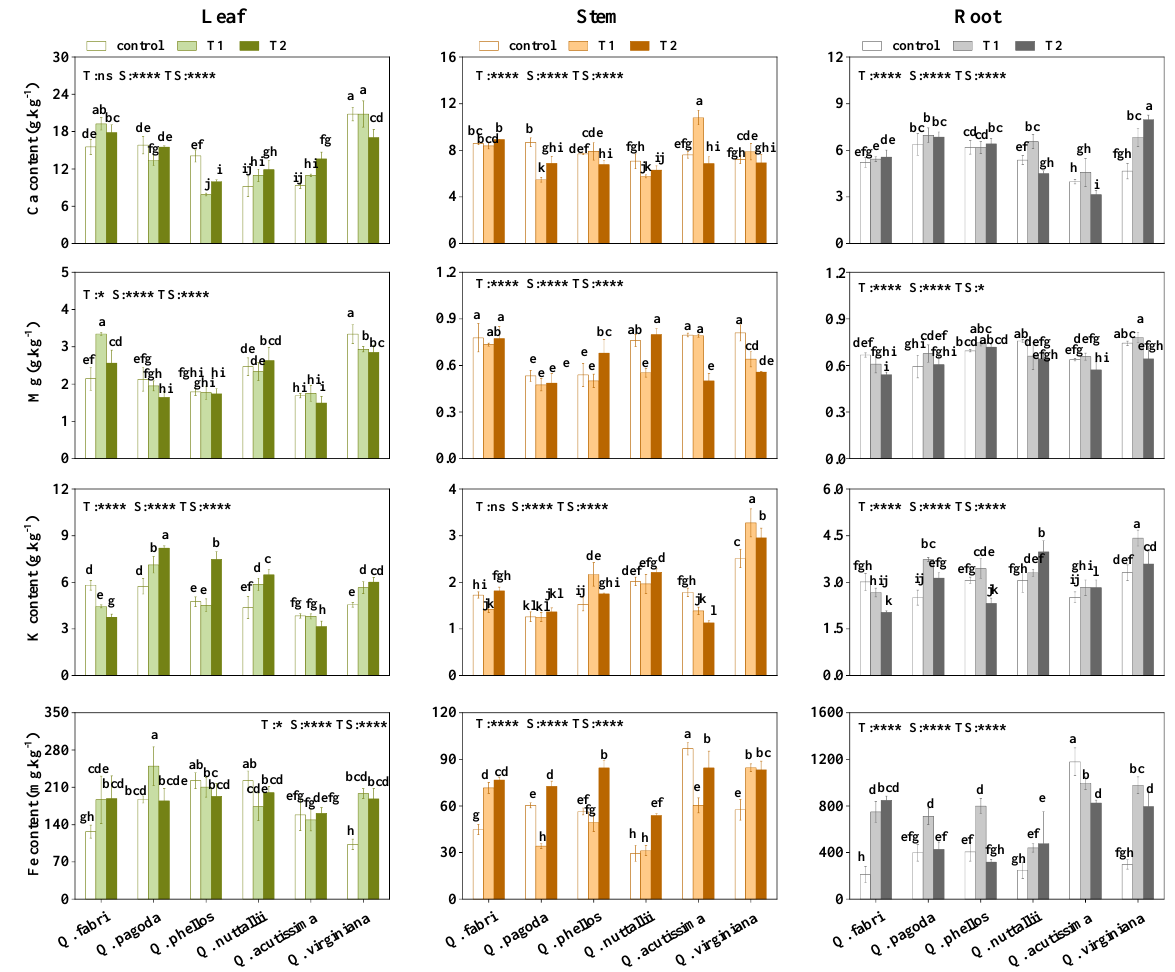
Figure 2. Nutrient elements (Ca, Mg, K, and Fe) of six Quercus species cultivated in control, T1 (mixture of clean and polluted soil, 50%), and T2 (100% polluted soil) treatments for 150 d. Data represent the mean of three replicates ± SD (n = 3). p values of the two-way ANOVAs of soil treatments (T), Quercus species (S), and their interactions (T × S) were also shown. ns, not significant; *, p ≤ 0.05; **** p ≤ 0.0001. The different letters showed the significance at level of